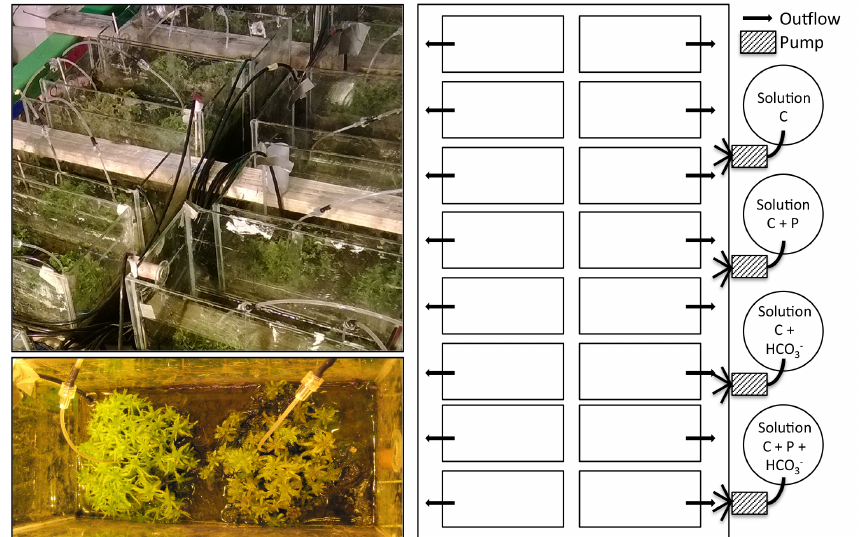
Figure 1. Picture of the mesocosms with rhizons inserted in the Sphagnum vegetation layer on top of the peat monoliths, placed in a temperature controlled water bath (left, up), close-up of 1 mesocosm (left, down), and the experimental design (right) showing the 16 mesocosms with water outflows and four treatment solution inflows: C (control), P addition (C + P), bicarbonate addition (C + HCO − P plus bicarbonate addition (C + P + HCO − ), each randomly assigned to 4 3